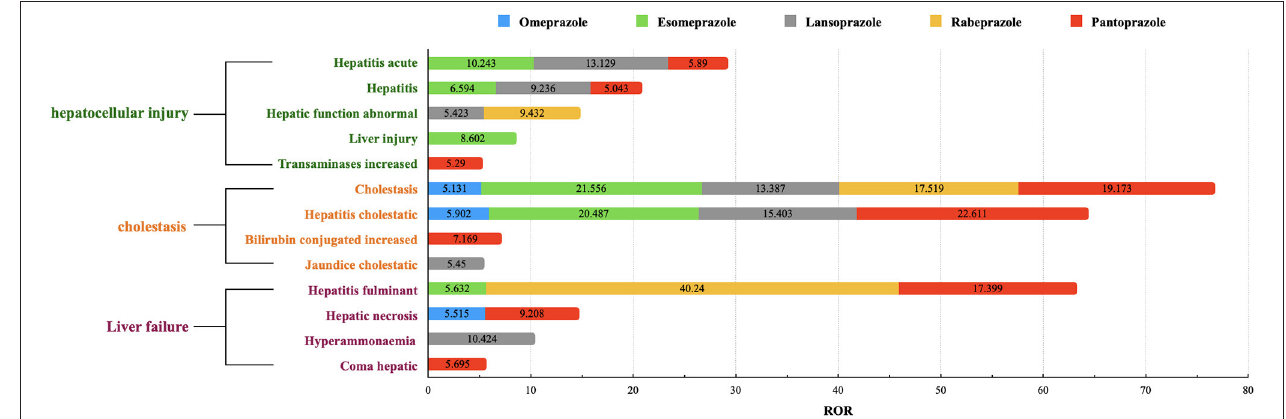
FIGURE 1 | The signals of RORs ≥ 5 in each PPI. The ROR value shown in this figure is a ROR value of a HRAE signal caused by a single PPI. We extracted signals with ROR ≥ 5 for each PPI, and integrated the RORs of the same signal to get this figure.